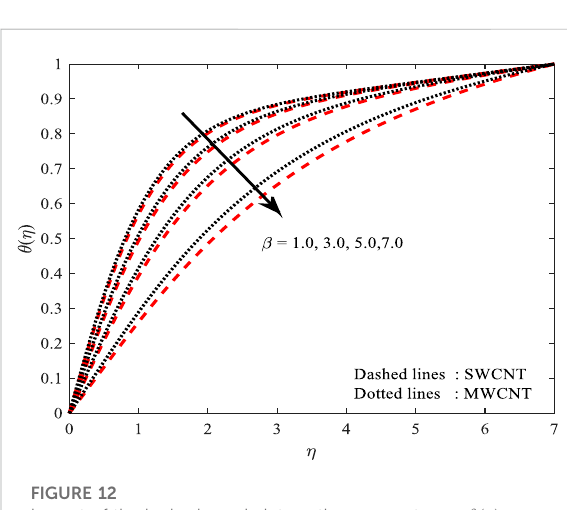
FIGURE 13 Impact of the hydrodynamic interaction parameter on θ p ( η ) .